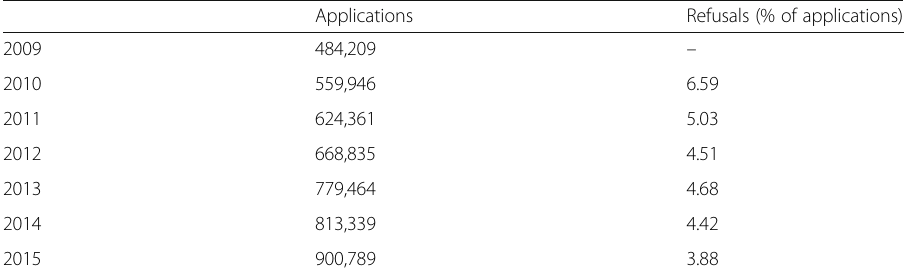
Table 2 Turkish citizens ’ Schengen visa applications and refusals